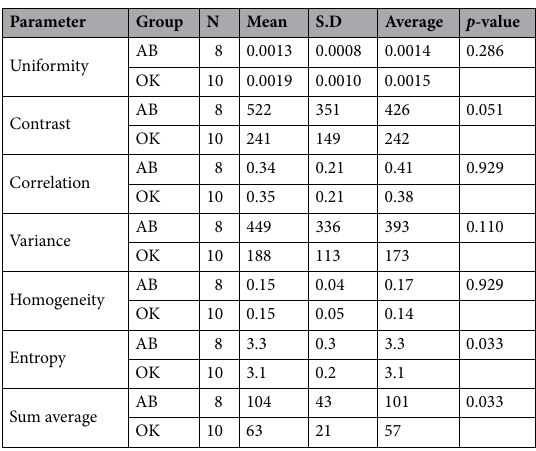
Table 3. Position and dispersion measurements of selected texture variables, by group and p-value of comparison between groups. N, Sample size; S.D., Standard deviation; Q1 and Q3, Distances in which each variable (parameter) was measured.